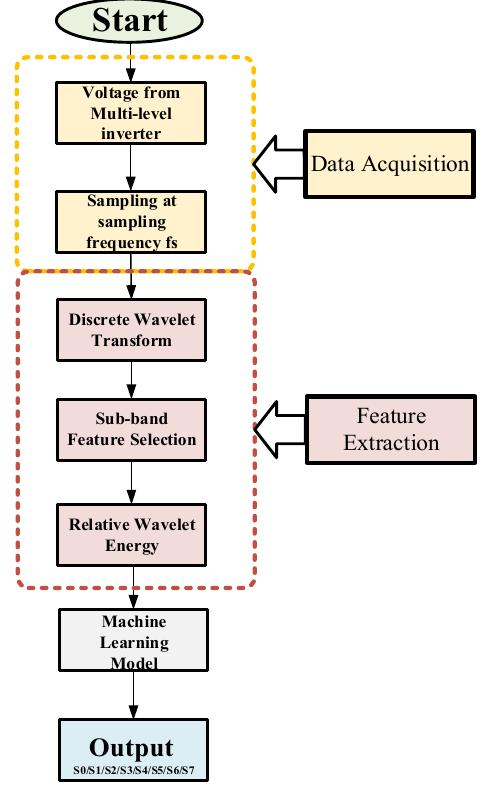
Figure 3. Flowchart of the diagnosis